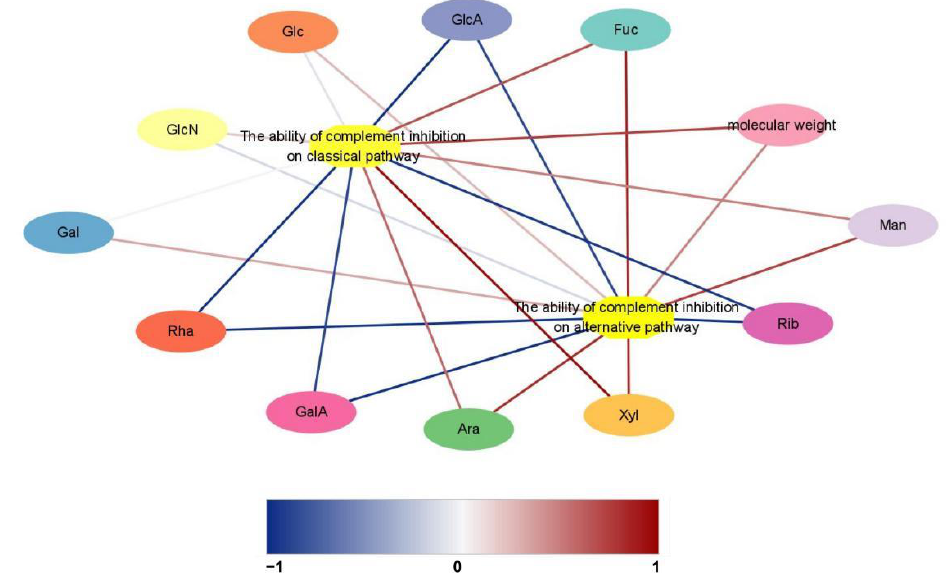
Figure 10. Network analysis of monosaccharide composition and molecular weight associated with the anti-complementary activity of CMPs. Red lines represent the positive correlation between structure and activity ( r > 0.99). Blue lines represent the negative correlation between structure and activity ( r > 0.99). The darker the line color, the higher is the significance of the correlation between structure and bioactivity.